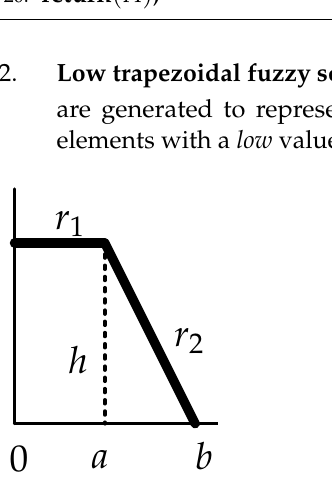
Figure 6. Low trapezoidal fuzzy set. After fixing the values a and b , we can calculate the lines r 1 and r 2 to obtain a trapezoid below them with area 1. Particularly, r 1 is defined as y = h , where h is a value chosen so that the value of the corresponding integral is 1: 1 = ah + On the other hand, r 2 is the line through the points and ( 0, b ) ,